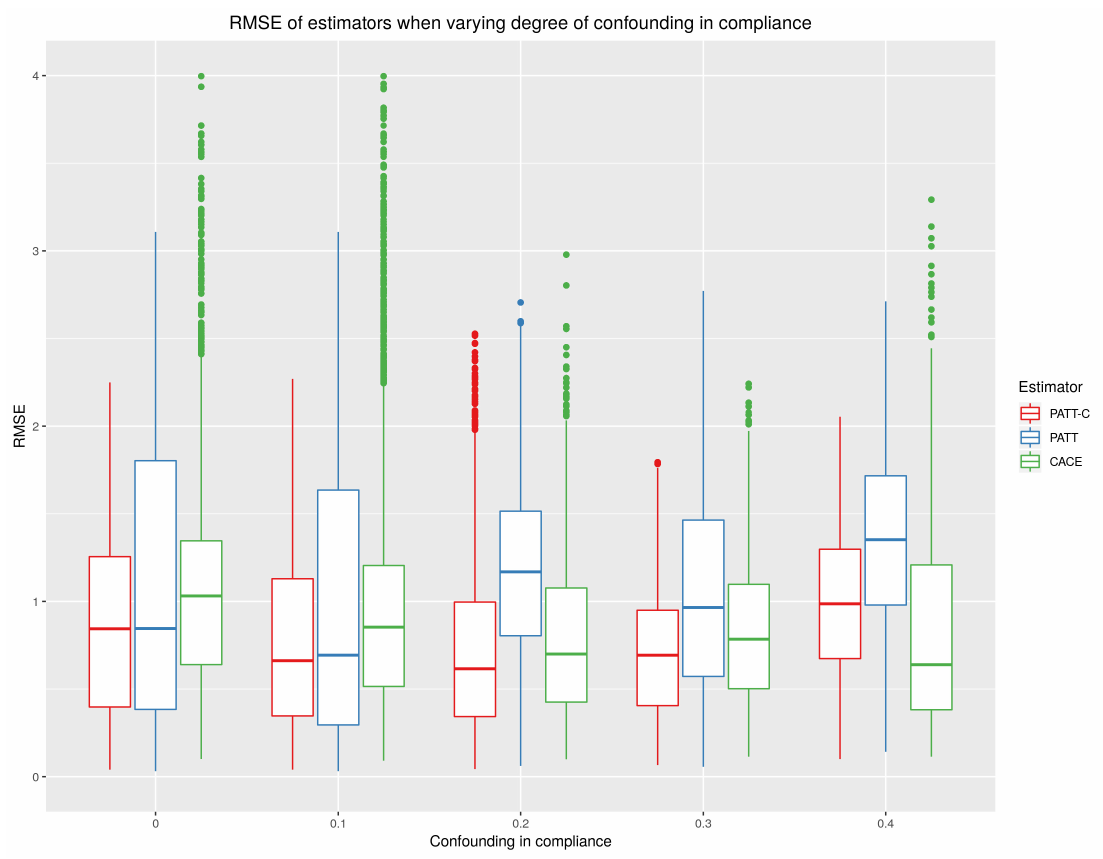
Figure B1: Average RMSE according to degree of confounding in compliance.